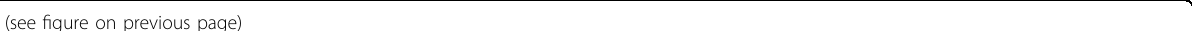
Fig. 1 Identi fi cation of CRISPR-Cas13 system and RNA-degrading capacity of the novel Cas13 protein. a Description of the bioinformatics pipeline used for identifying novel Cas13 families. b Overlapping of novel Cas13 proteins with proteins of previously discovered Cas13 subtypes, which are known or unannotated in the NCBI and metagenomic databases. c Distribution of the number of novel Cas13 subtypes. d Dendrogram constructed using the unweighted pair group method with arithmetic mean (UPGMA) algorithm. From top to bottom, n = 502, 51, 411, 7, 8, 27, 22, 8, 14, 18, and 925. e Maximum likelihood tree of the Cas13 families. f Distribution of the size of the proteins in the different Cas13 subtypes. From left to right, n = 151, 281, 21, 52, 18, 8, 7, 22, 14, 8, and 27. g Schematic diagram depicting the size of the Cas13 proteins and the position of the HEPN motif. h Comparison of the gene knockdown ef fi ciency using crRNAs with 3 ′ - or 5 ′ -DR sequences (means ± s.d.; n = 3 biological replicates; Student ’ s t -test, ns not signi fi cant, *** P < 0.001, **** P < 0.0001). Normalized MFI, mean fl uorescence intensity (MFI) relative to the non-targeting condition. i Measurement of ANXA4 mRNA knockout mediated by the novel Cas13 systems in HEK293T cells using quantitative reverse transcription PCR (RT- qPCR) (means ± s.d.; n = 3 biological replicates). Normalized expression, relative expression was normalized to the non-targeting condition. NT non- targeting crRNA. j Evaluation of the cleavage activity of Cas13 proteins by targeting the mRNAs of endogenous genes using RT-qPCR in HEK293T cells (means± s.d.; n = 3 biological replicates). Normalized expression, relative expression was normalized to the non-targeting condition. NT non- targeting crRNA. k Comparison of the endogenous gene knockdown activity of Cas13X.1, RfxCas13d, and Cas13e3 (means ± s.d.; n = 15 for each protein; paired t -test, ns not signi fi cant). Normalized expression, relative expression was normalized to the non-targeting